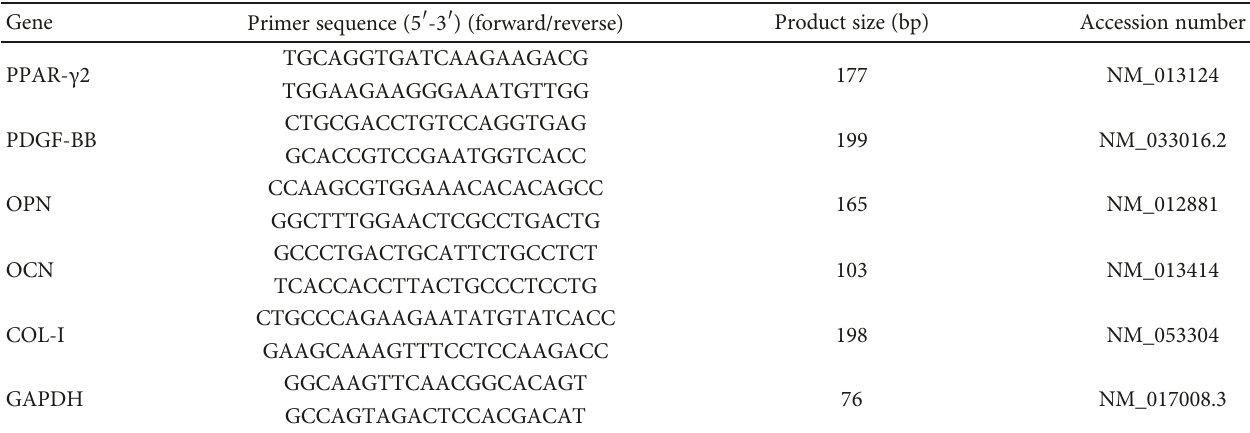
Table 1: Nucleotide sequences for real-time RT-PCR